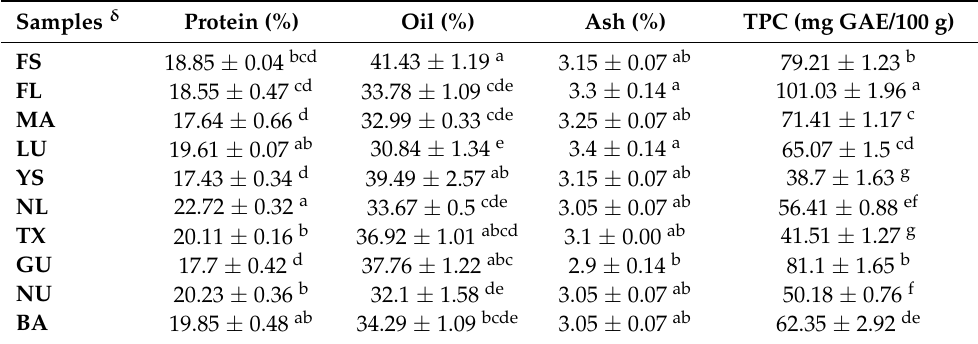
Table 1. Some physicochemical and bioactive properties of almond